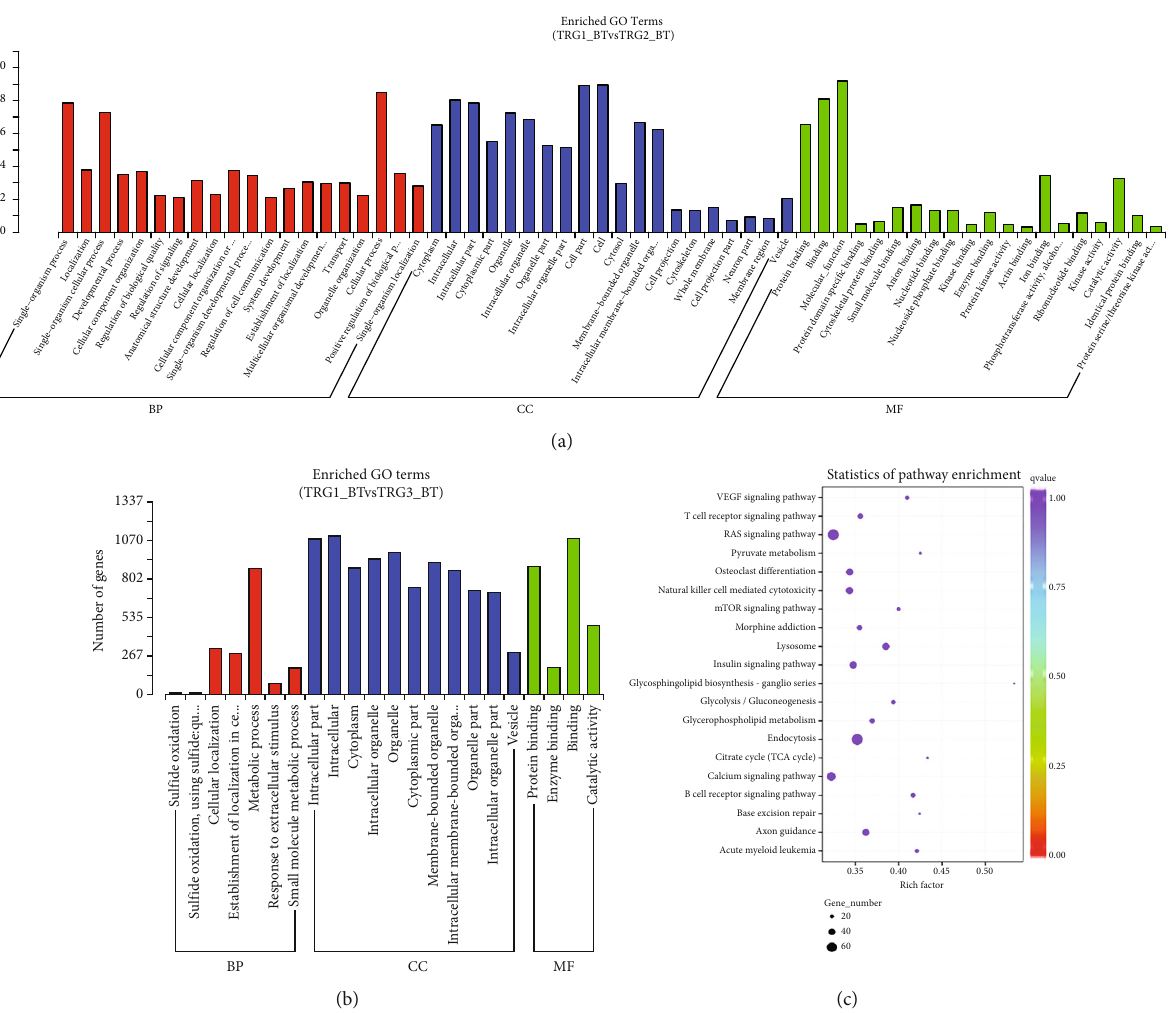
Figure 2: Functional enrichment analysis of di ff erentially expressed miRNA target genes. (a) GO analysis of the TRG1 and TRG2 groups. (b) GO analysis of the TRG1 and TRG3 groups. (c) KEGG enrichment